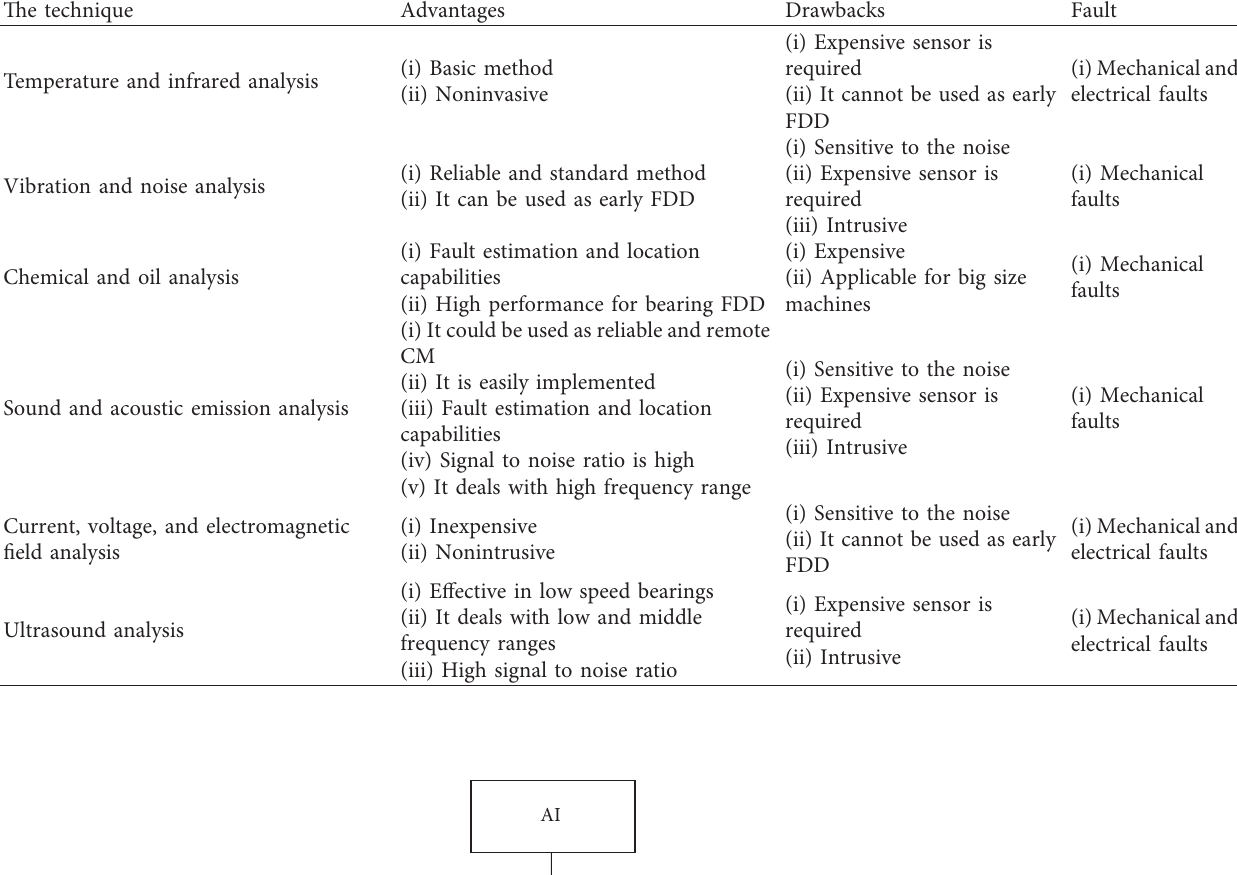
Table 1: Comparison between various CM analysis techniques for bearings of IM.